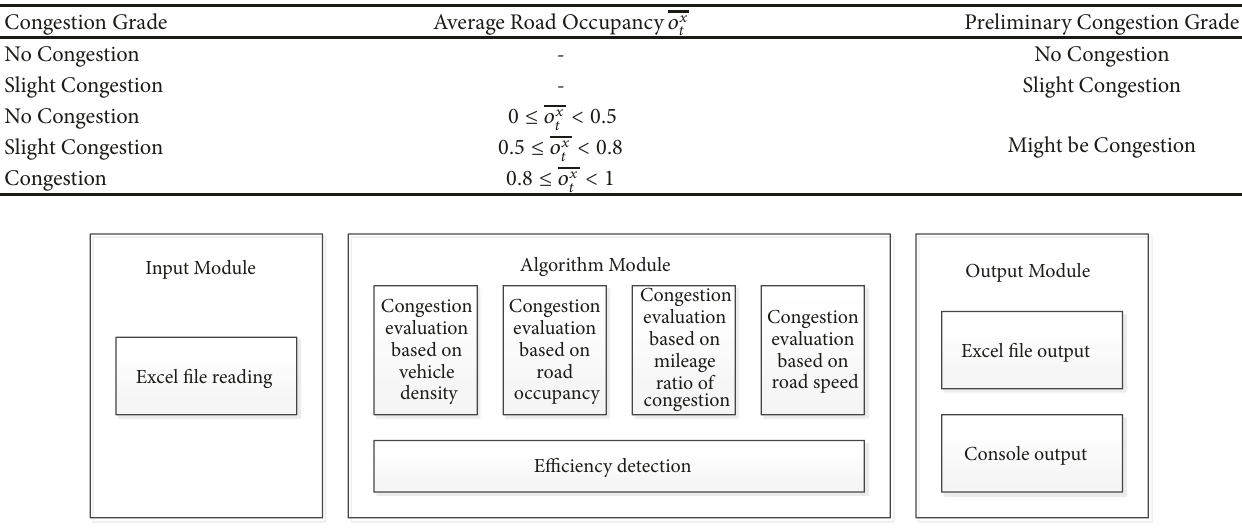
Figure 1: The framework for crosswise comparison between different congestion evaluation